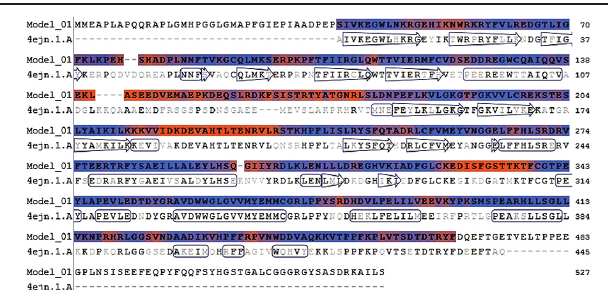
figurE 9 − Phosphoinositide 3-kinase (PI3K)/AKT – model – template alignment